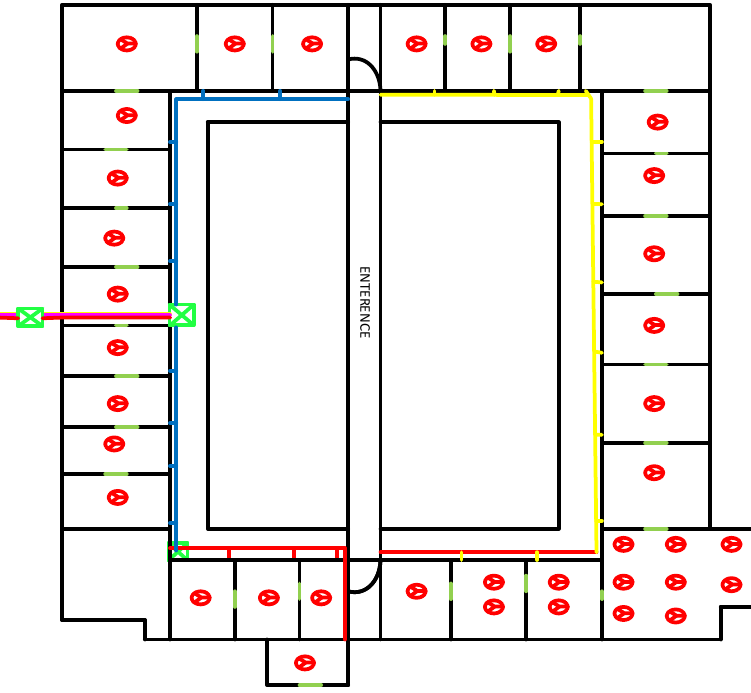
Figure 18. The proposed model for the Rahman Baba Hostel.